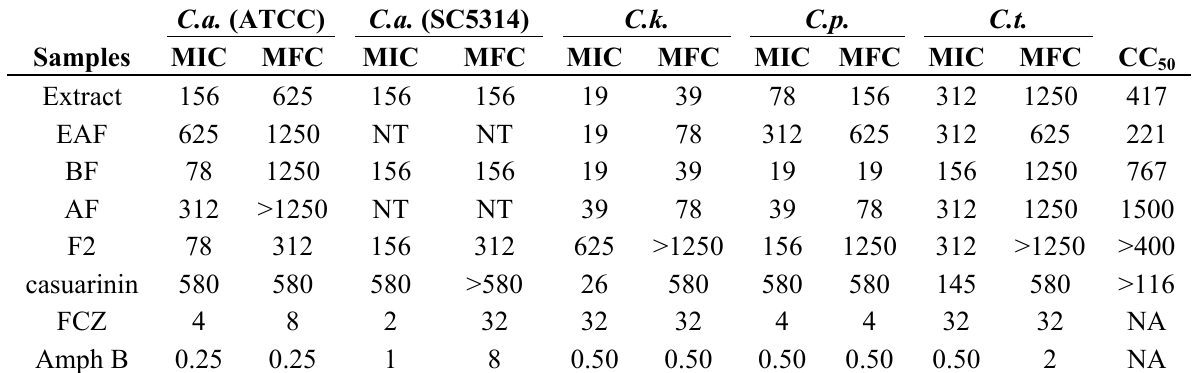
Table 1. Antifungal activity and cytotoxicity of P. cauliflora leaf samples, in